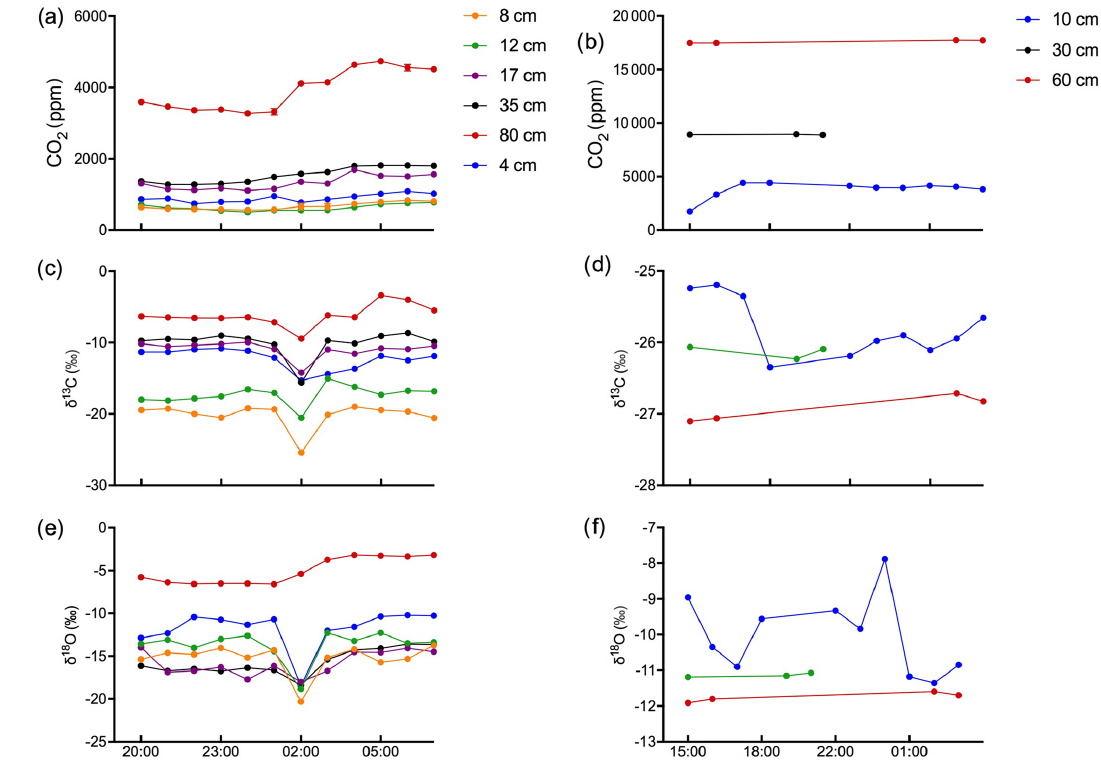
Figure 9. Time course of the evolution of soil gas CO 2 (ppm), δ 13 C, and δ 18 O in calcareous (a, c, e) and acidic (b, d, f) soils. Data collected continuously over a 12h time frame for the calcareous soil and a 14h time window with intermittent data collection for the acidic